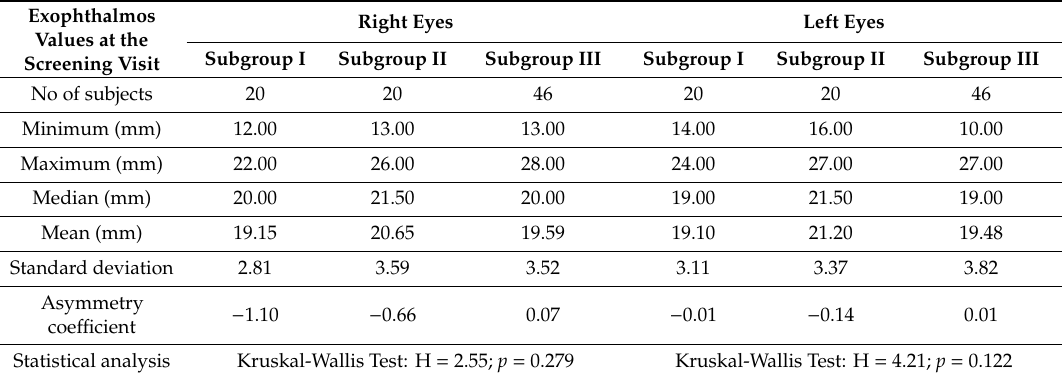
Table 5. EXO values analysis in the study participant’s right and left eyes at the screening visit.